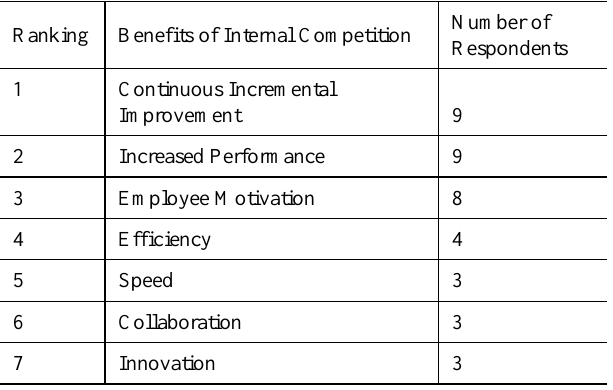
Table 2: Benefits of internal competition